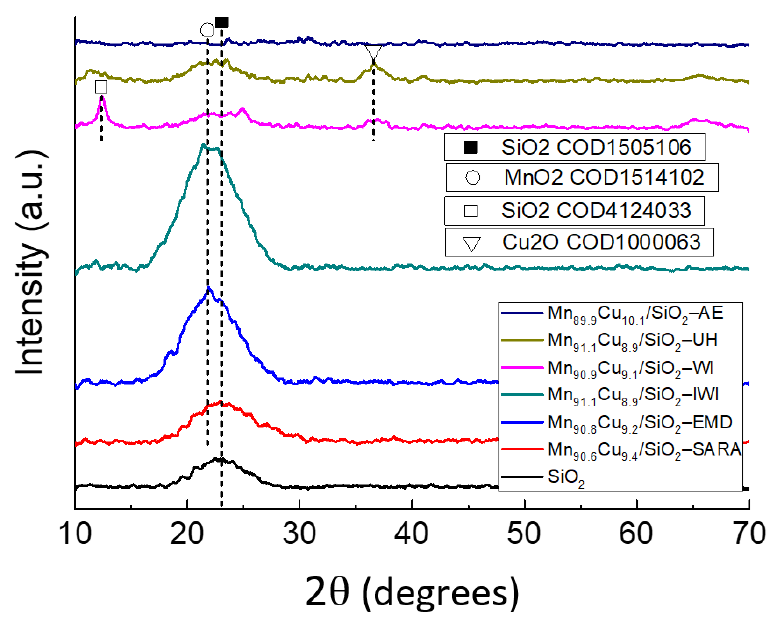
Figure 7. XRD patterns for the Mn–Cu oxide catalysts supported by the silica gel powder.